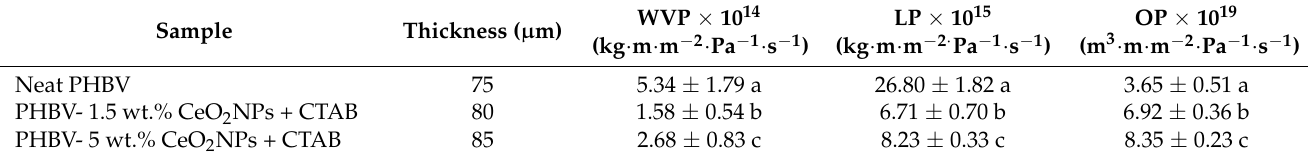
Table 5. Comparison of the water vapor permeability (WVP), D-limonene permeability (LP), and oxygen permeability (OP) of the prepared samples based on electrospun poly(3-hydroxybutyrate-co- 3-hydroxyvalerate) (PHBV) films loaded with cerium oxide nanoparticles (CeO 2 NPs) and hexade- cyltrimethylammonium bromide